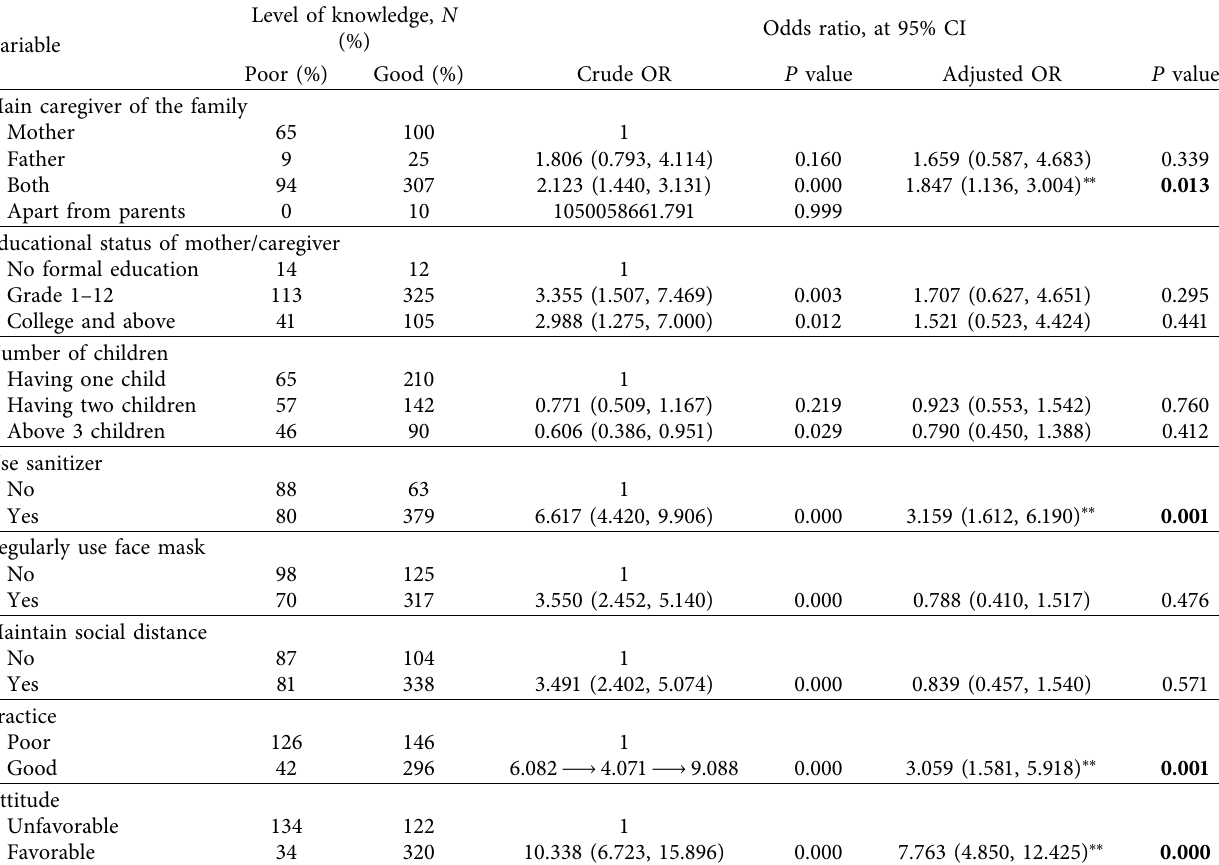
Table 6: Factors associated with the knowledge of mothers about COVID-19 in Dessie town, Ethiopia,